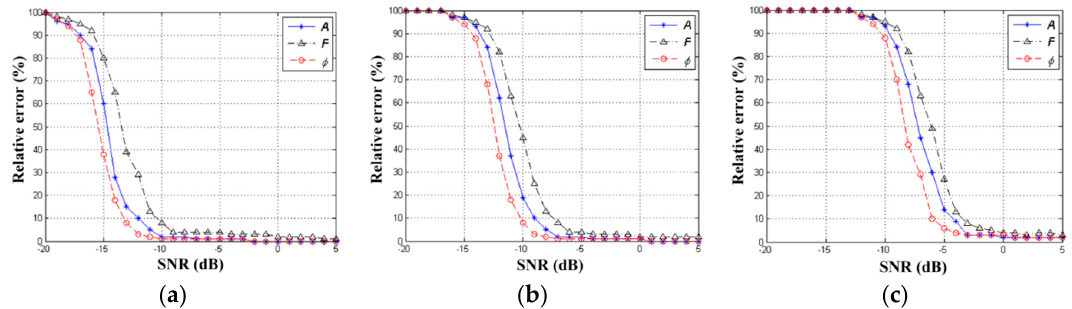
Figure 11. Relative errors versus different Set the signal-to-noise ratios (SNRs). ( a ) Result of T1. ( b ) Result of T2. ( c ) Result of T3.